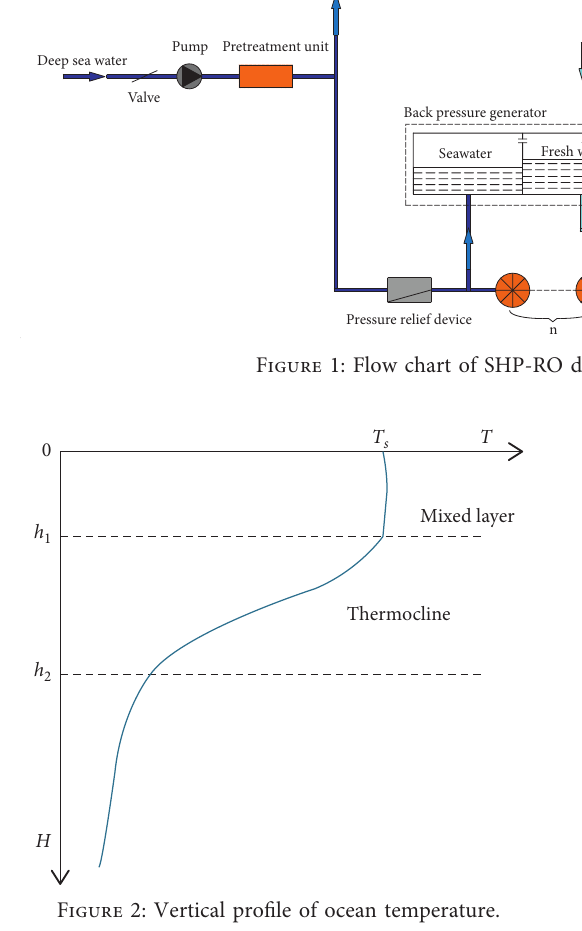
Figure 3: Relationship between depth, membrane flux, and membrane